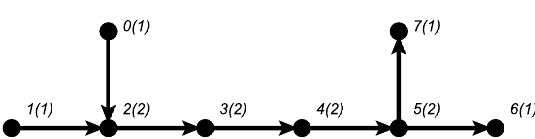
Figure 1. Oriented b D 7 quiver. The numbers in the parentheses represent the Coxeter labels d i